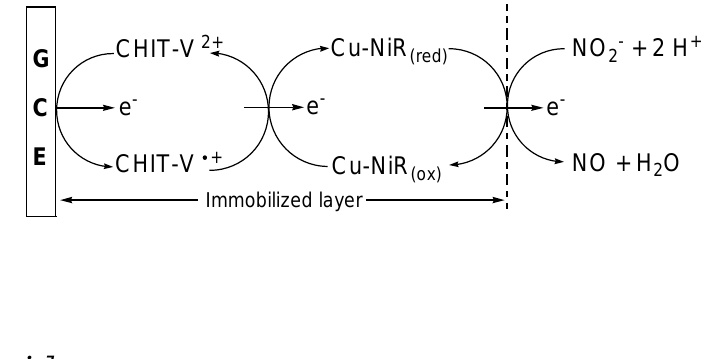
Figure 1. Scheme of working principle of the co-immobilized Cu-NiR and CHIT-V